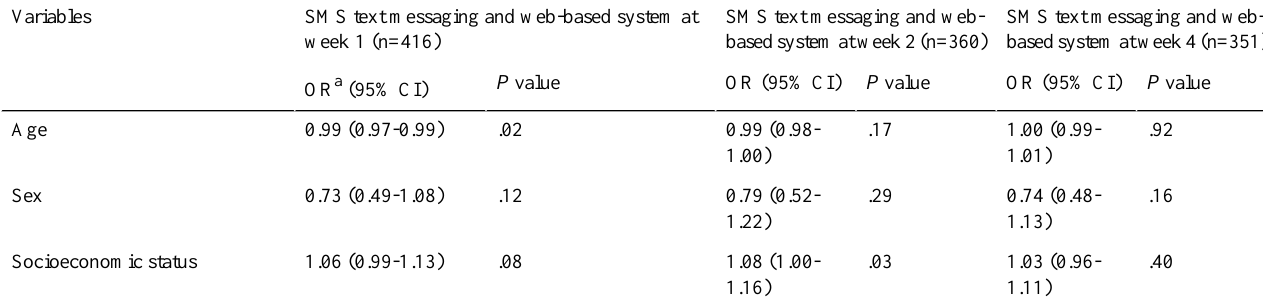
Table 4. Associations of age, sex, and socioeconomic status with response method (SMS text messaging and web-based or telephone).